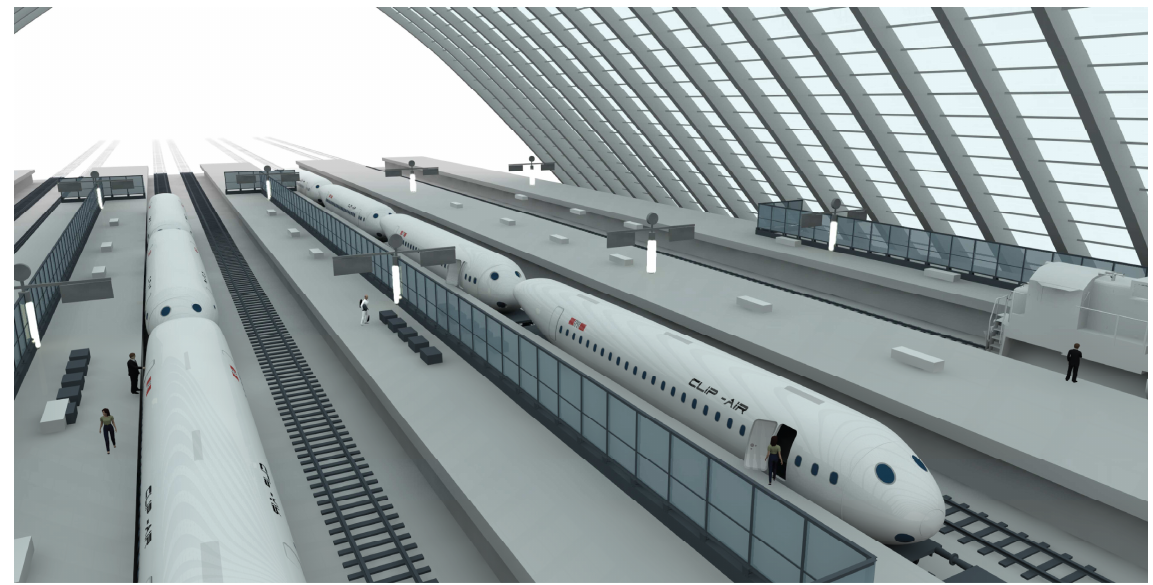
Figure 2. Demonstration of Clip-Air capsules at a railway